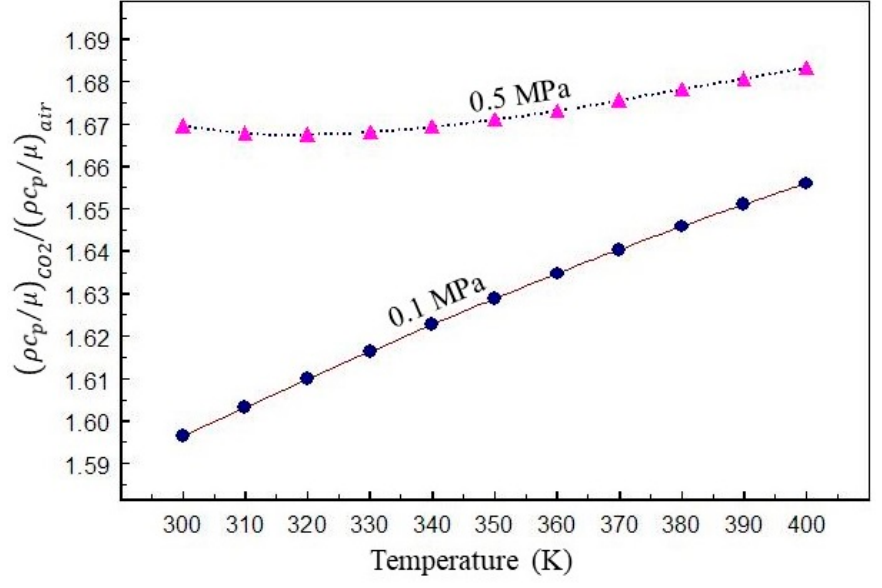
Figure 2. Flow heat capacity of gaseous CO 2 and air.